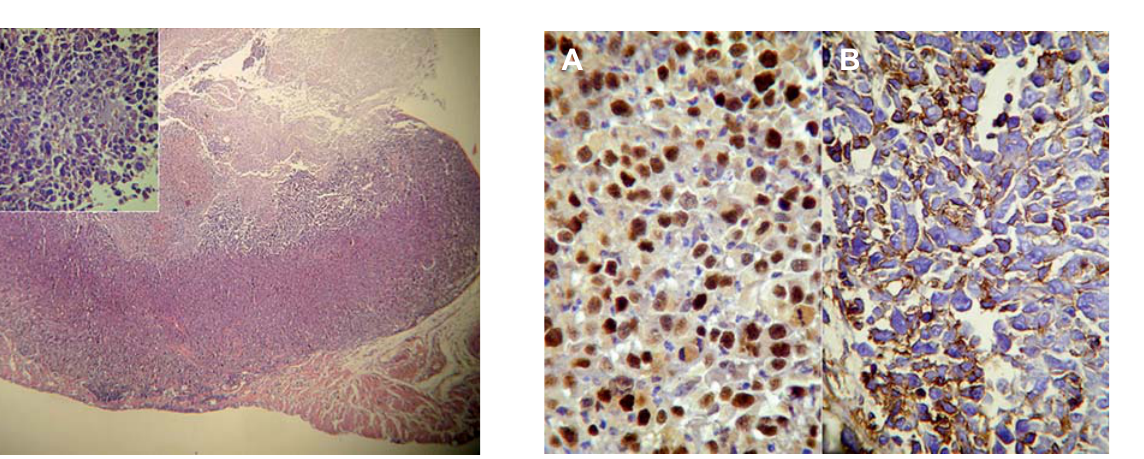
Figure 3 – Photomicrography, hematoxylin and eosin-stained slide showing an invasive orthotopic urothelial bladder tumor in the bladder wall with a great amount of necrosis. The statistical (cid:68)(cid:81)(cid:68)(cid:79)(cid:92)(cid:86)(cid:76)(cid:86)(cid:3)(cid:86)(cid:75)(cid:82)(cid:90)(cid:72)(cid:71)(cid:3)(cid:87)(cid:75)(cid:68)(cid:87)(cid:3)(cid:87)(cid:88)(cid:80)(cid:82)(cid:85)(cid:86)(cid:3)(cid:90)(cid:72)(cid:85)(cid:72)(cid:3)(cid:86)(cid:76)(cid:74)(cid:81)(cid:76)(cid:191)(cid:70)(cid:68)(cid:81)(cid:87)(cid:79)(cid:92)(cid:3)(cid:86)(cid:80)(cid:68)(cid:79)(cid:79)(cid:72)(cid:85)(cid:3)(cid:76)(cid:81)(cid:3)(cid:80)(cid:76)(cid:70)(cid:72)(cid:3) submitted to curcumin treatment.